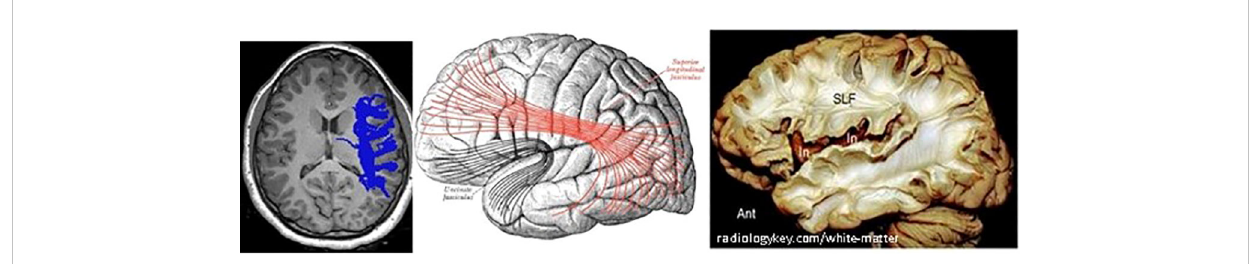
FIGURE 9 Right SLF white matter. Left: axial view of one diabetes patient (c016), right SLF pathway as traced by AFQ – Center: diagram showing the lateral surface of the left cerebral hemisphere. SLF is at the center, in red. Right: dissection of the human brain from the lateral aspect by the Klingler technique. Resecting the super fi cial digitations exposes the superior longitudinal fasciculus (SLF) superior to the sylvian fi ssure and insula